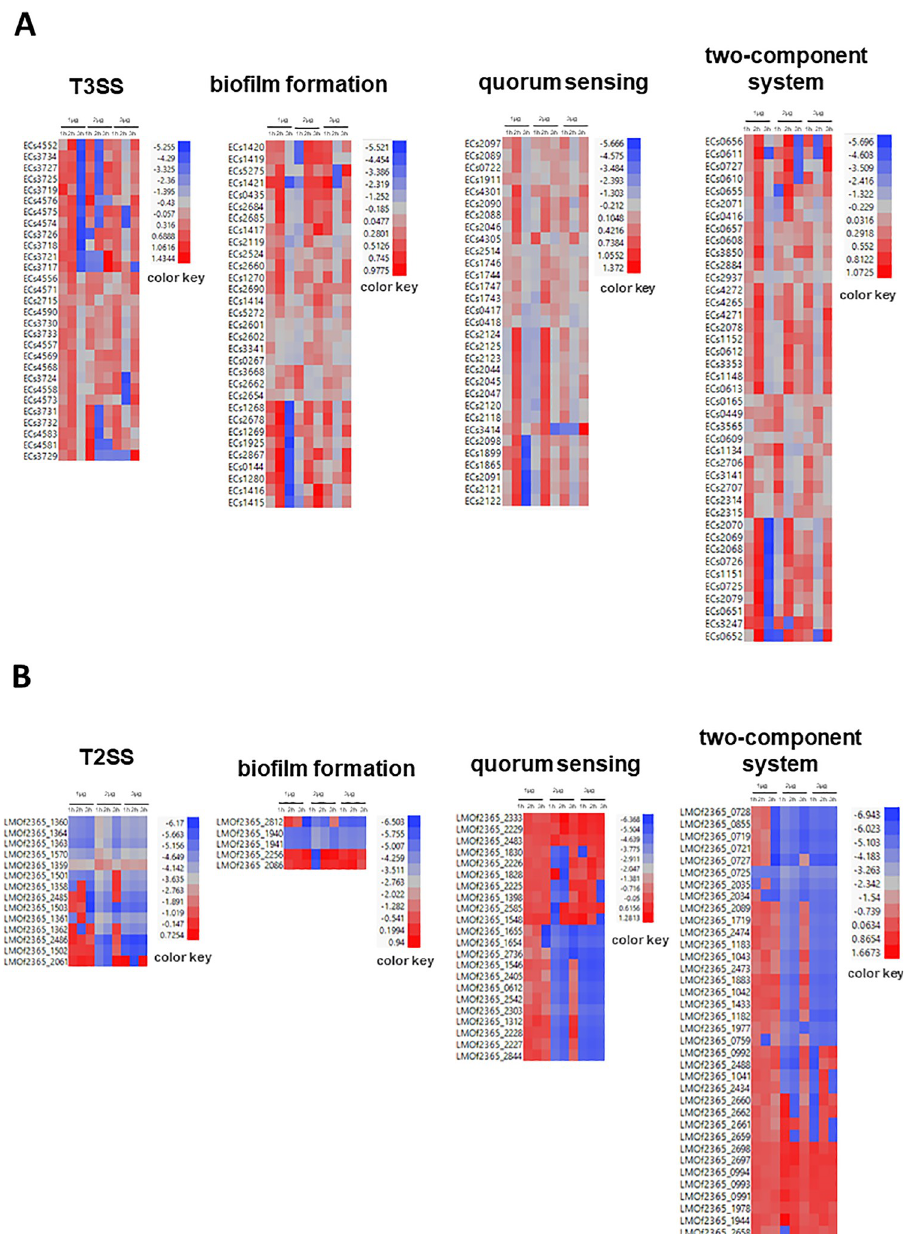
Fig 5. Hierarchical clustering heat map of differentially expressed E . coli (A) and L . monocytogenes (B) genes associated with pathogenesis and stress response. PS of genes in response to O 3 treatments after 1 hr, 2 hr and 3 hr were plotted. Red indicates high expression and green indicates low